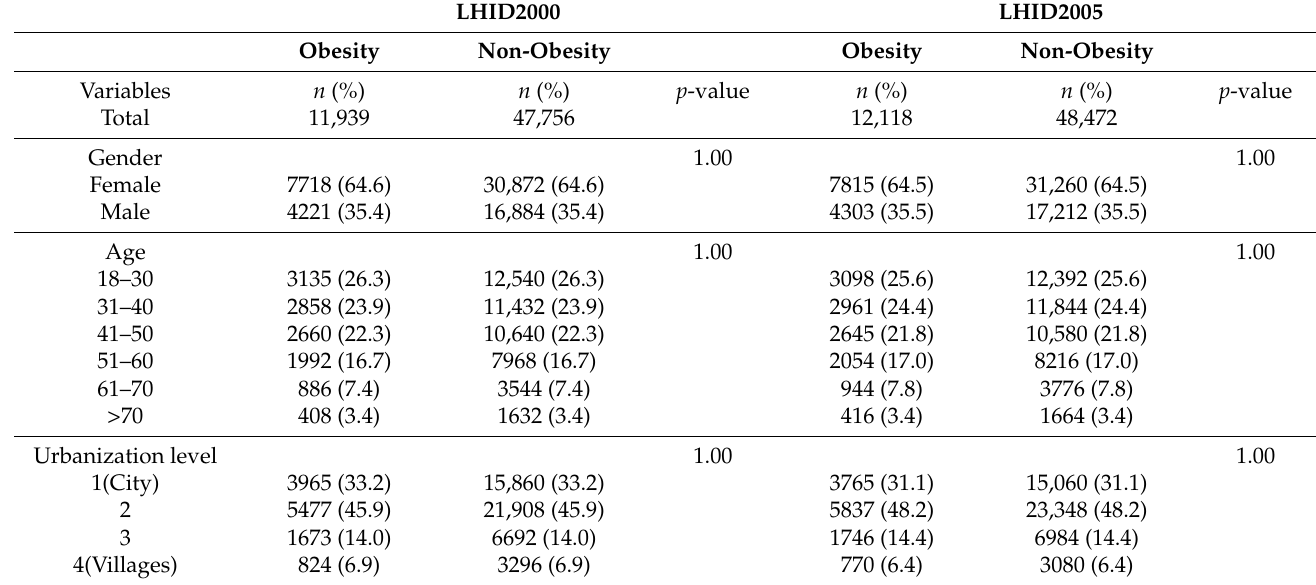
Table 1. Baseline characteristics with incidence of open-angle glaucoma in obese and non-obese